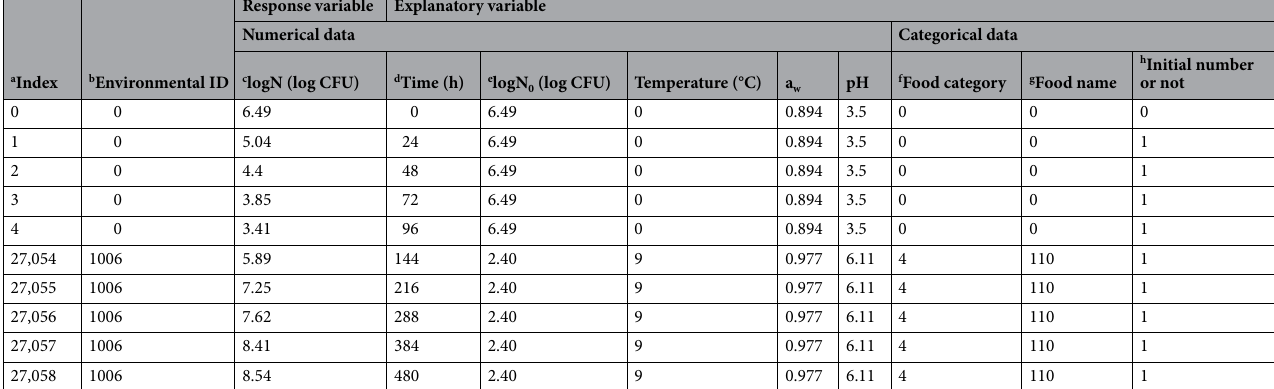
Table 2. Sample of product characteristics and storage conditions for the collected dataset. a Index: serial number of viable cell count data. b Environmental ID: serial number of environmental condition. c logN: logarithmic of viable cell number. d Time: elapsed time. e logN 0 : logarithmic of initial cell number. f Food Category: number of food category (0: culture medium, 1: seafood, 2: vegetable, 3: beef, 4: pork). g Food Name: number of food name (0–111), which is described in Supplementary Data S2. h Initial number or not: dummy variable showing whether the viable cell number is the initial cell number (0: initial cell number, 1: not initial cell